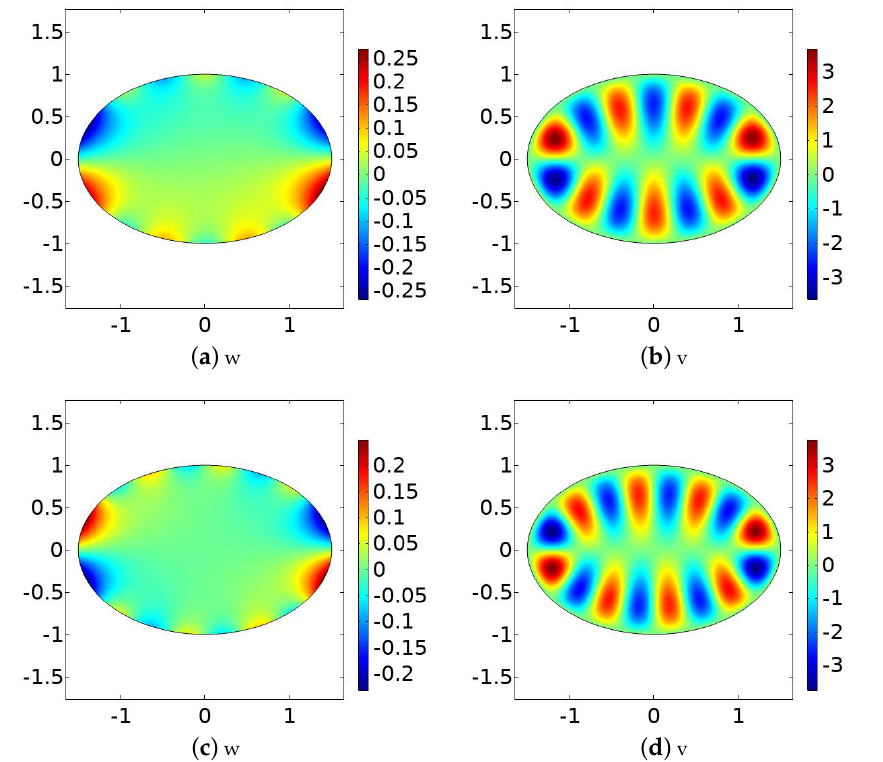
Figure 10. The magnitude of transmission eigenfunctions for an ellipse with the semi-major radius 1.5 and the semi-minor radius 1. ( a , b ): k = 8.736; ( c , d ): k =